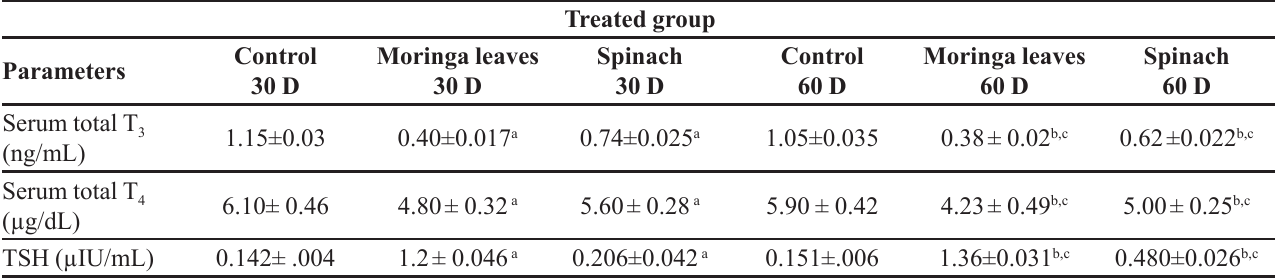
TABLE II - Effect of selected plant-foods on total serum triiodothyronine (T hormone (TSH) levels in experimental animals treated for 30 days and 60 days respectively